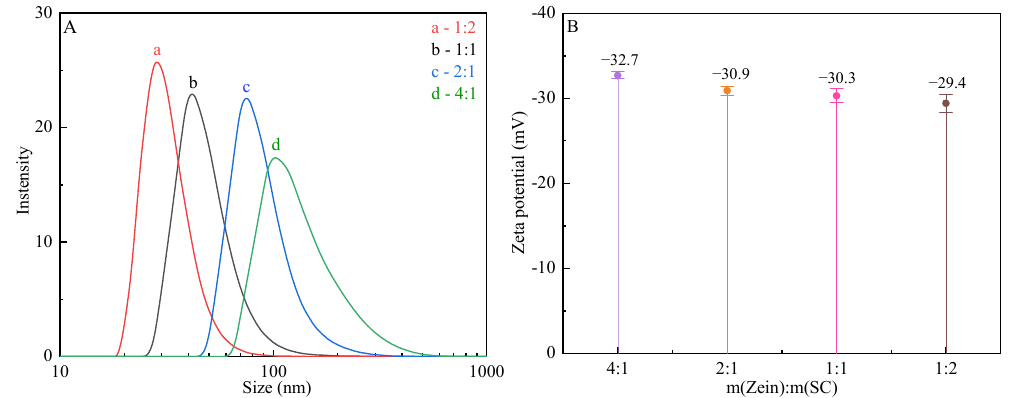
Figure 3. The effect on particle size distribution and potential of zein/SC composite NPs with different mass ratios (1:2, 1:1, 2:1, and 4:1), ( A ) particle size distribution, ( B ) zeta potential.